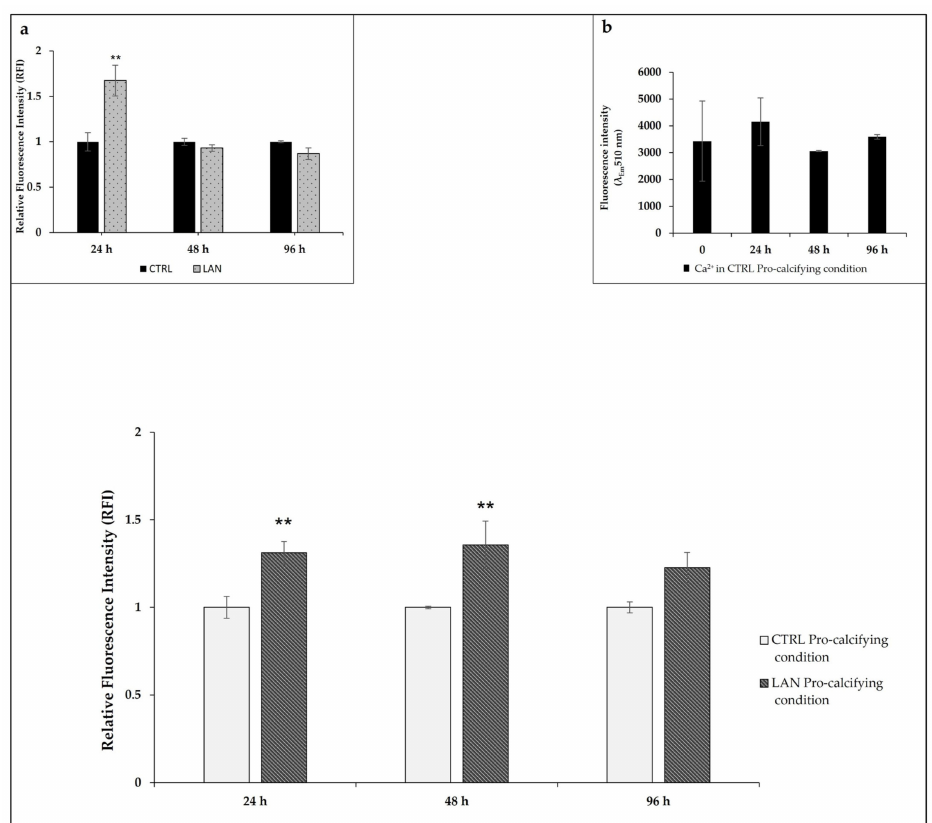
Figure 2. The effects of lanthionine on intracellular calcium levels using a fluorescent Fura 2-AM probe in EA.hy926 cultures. The effect of 1 µ M of lanthionine treatment with 2.8 mM of CaCl 2 and 3 mM of NaH 2 PO 4 after 24 h, 48 h and 96 h on intracellular Ca 2+ levels in endothelial cells. Ca 2+ levels were detected using the fluorescent probe Fura 2-AM and were expressed as RFI as explained under “Materials and Methods.” Inset ( a ): the effect of 1 µ M of lanthionine treatment after 24 h, 48 h and 96 h on intracellular Ca 2+ levels in endothelial cells. Ca 2+ levels were detected using the fluorescent probe Fura 2-AM and were expressed as RFI, as above. Inset ( b ): the effect of pro-calcifying conditions on intracellular Ca 2+ levels after 0, 24 h, 48 h and 96 h of treatment. The columns represent the mean, while the error bars are the SD from three independent experiments; p -value versus untreated or treated control = ** p < 0.01, (according to the Anova test). CTRL, untreated control; LAN, lanthionine; CTRL Pro-calcifying condition, with 2.8 mM CaCl 2 and 3 mM of NaH 2 PO 4 ; LAN Pro-calcifying condition, lanthionine with 2.8 mM CaCl 2 and 3 mM of NaH 2 PO 4